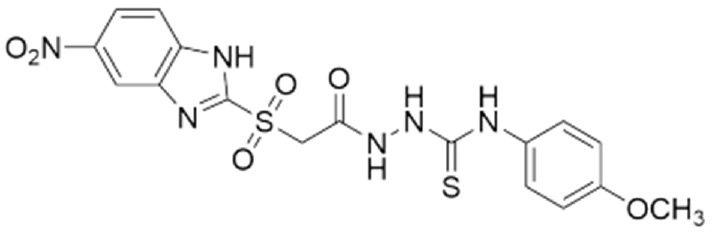
Figure 1. Chemical structure of the active pharmaceutical ingredient (API): 1-(5 ′ -nitrobenzimidazole-2 ′ -yl-sulphonyl-acetyl)-4-aryl-thiosemicarbazide.